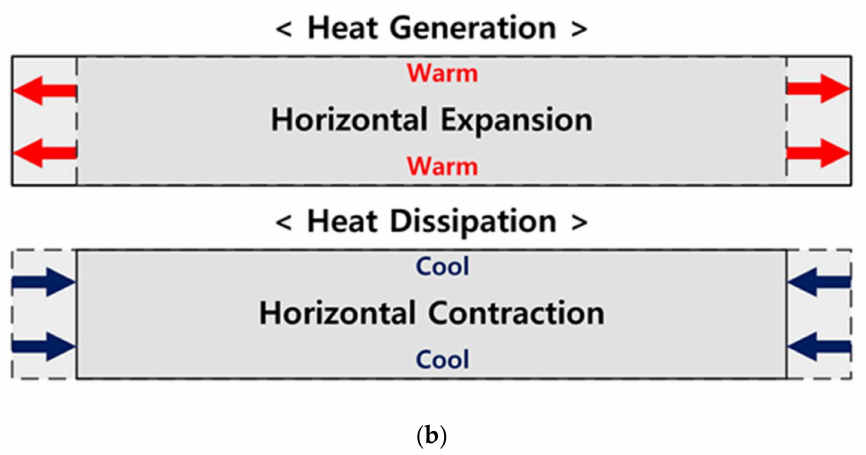
Figure 13. Early age behavior of concrete slab estimated by the real strain: ( a ) due to daily temperature variation and ( b ) due to generation and dissipation of heat of